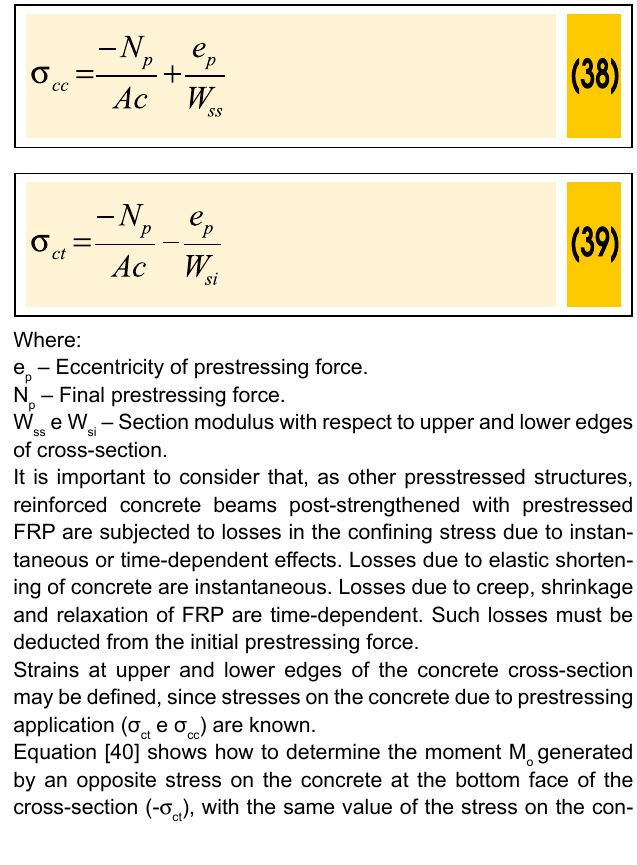
section in this